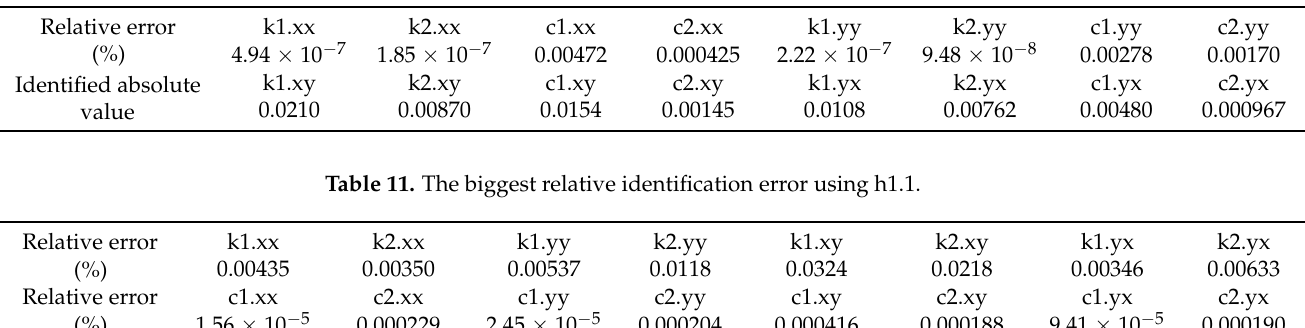
Table 10. The biggest relative identification error of main coefficients and the maximum identified absolute value of cross-coupled coefficients using g1.4.